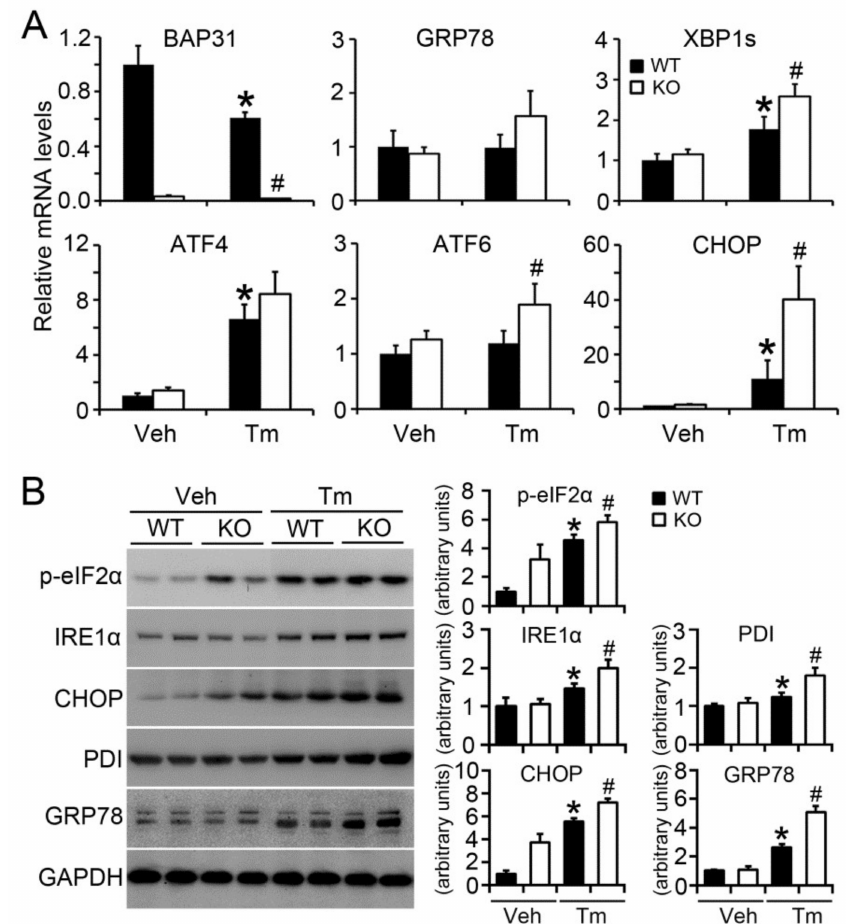
Figure 5. BAP31 deficiency increased Tunicamycin-induced ER stress. ( A ) The relative mRNA levels of ER stress markers, including GRP78 , XBP1s , ATF4 , ATF6 and CHOP , was determined in mice livers injected with vehicle (Veh) of Tunicamycin (Tm) for 48 h. n = 7 to 8 per group. ( B ) Immunoblot assay of p -eIF2 α , IRE1 α , CHOP, PDI and GRP78 in mice livers injected with vehicle (Veh) or Tunicamycin (Tm) for 48 h. GAPDH was used as a loading control. Data represent as mean ± SEM. *, p < 0.05, Tm compared with Veh group. #, p < 0.05, KO compared with WT mice injected with